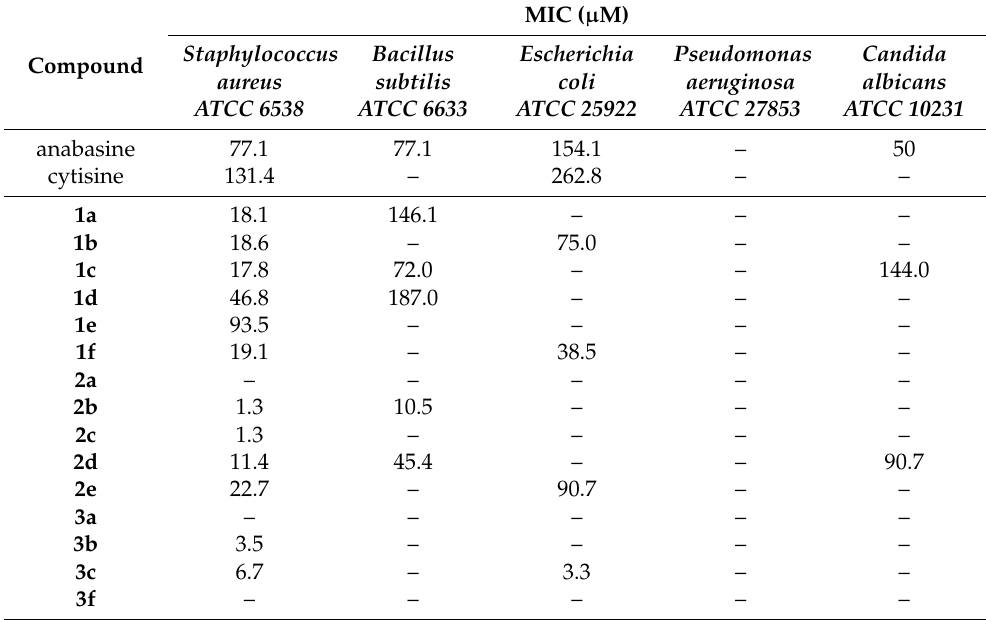
Table 3. Minimum inhibitory concentration (MIC) of test compounds in relation to reference test